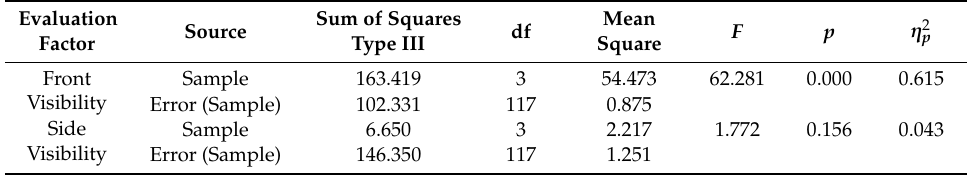
Table 11. Results of three-way mixed ANOVA for front / side visibility (Test result of within subject e ff